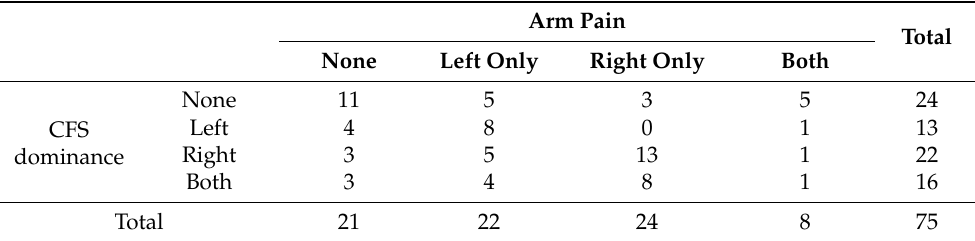
Table 4. Distribution of CFS dominance according to total counts of CFS ≥ grade 3 on left and right sides and arm pain sidedness.